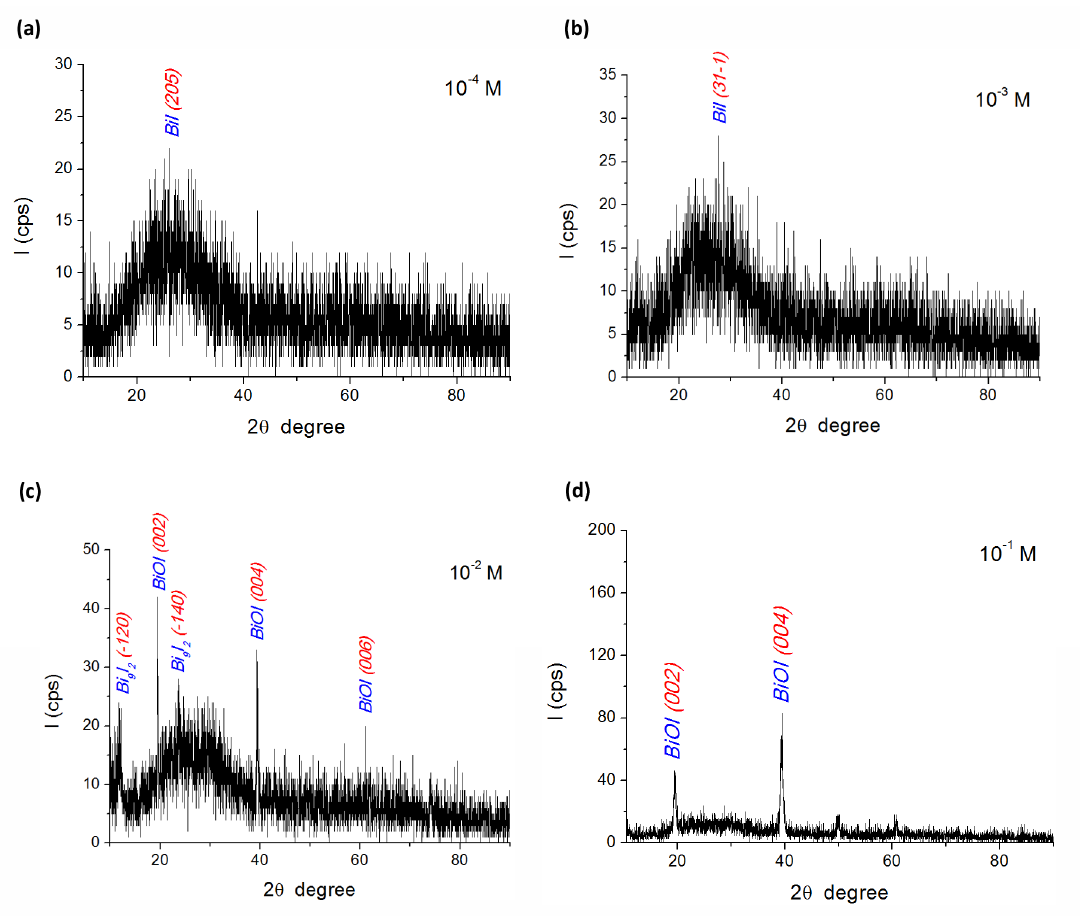
Fig. 1. X-ray patterns of the films deposited in bath solution with: (a) 10 -4 M, (b) 10 -3 M, (c) 10 -2 M and (d) 10 -1 M concentrations.